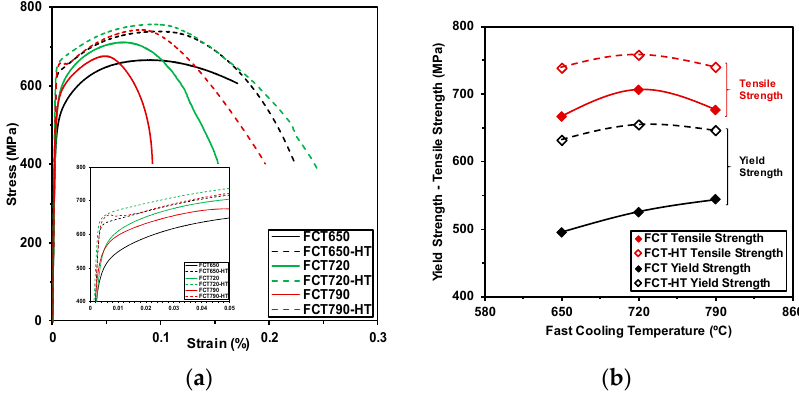
Figure 3. ( a ) Engineering tensile curves obtained for all of the Fast Cooling Temperatures (FCTs). Tensile curves measured before (FCT) and after induction heat treatment (FCT-HT) have been included. ( b ) Evolution of yield strength and tensile strength as a function of the Fast Cooling Temperature (samples obtained before and after induction treatment).